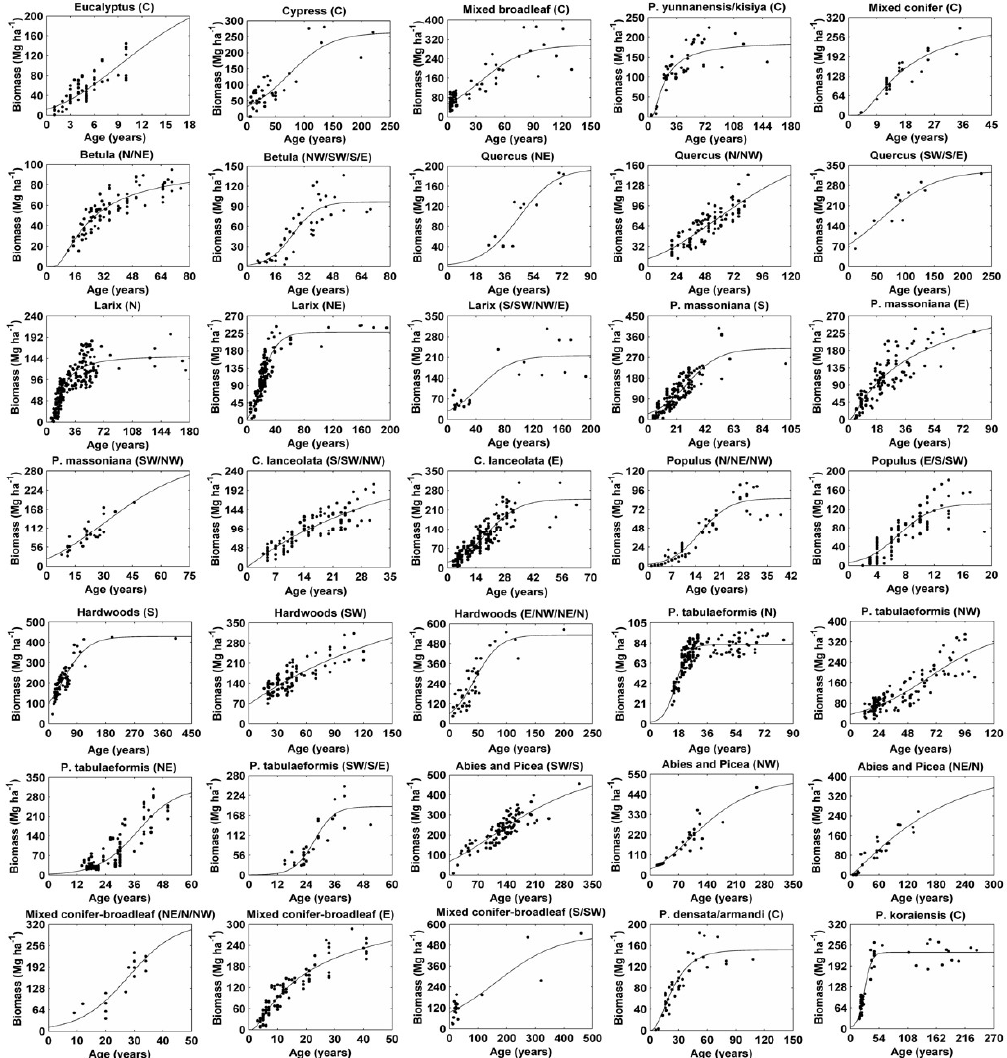
Figure 2. Fitted biomass–age relationships of major forest types in different regions of China. C, E, N, NE, NW, S, and SW are abbreviations for China, and the eastern, northern, northeastern, northwestern, southern, and southwestern regions, respectively. C. and P. are abbreviations of Cunninghamia and Pinus , respectively.